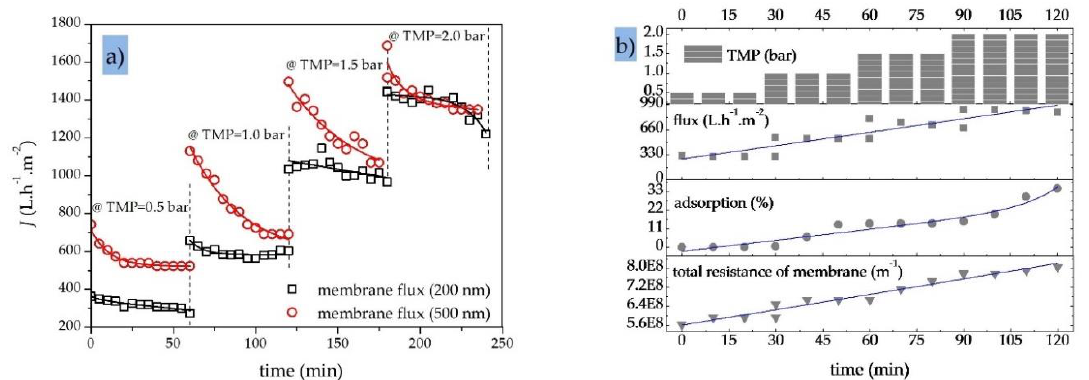
Figure 9. Performance of SiC MF membranes. ( a ) Membrane fluxes for two SiC MF membranes (200 and 500 nm) at varying TMPs (0.5, 1.0, 1.5 and 2.0 bar); CFV = 1.0 m · s − 1 ; OMS initial oil concentration = 100 ppm; T = 40 ◦ C; total recycle mode. ( b ) Variations in permeate flux, oil adsorption and total membrane residence for a SiC MF membrane (200 nm) at varying TMPs (0.5, 1.0, 1.5 and 2.0 bar); CFV = 1.0 m · s − 1 ; initial oil concentration in feed = 200 ppm; T = 40 ◦ C; total recycle mode.